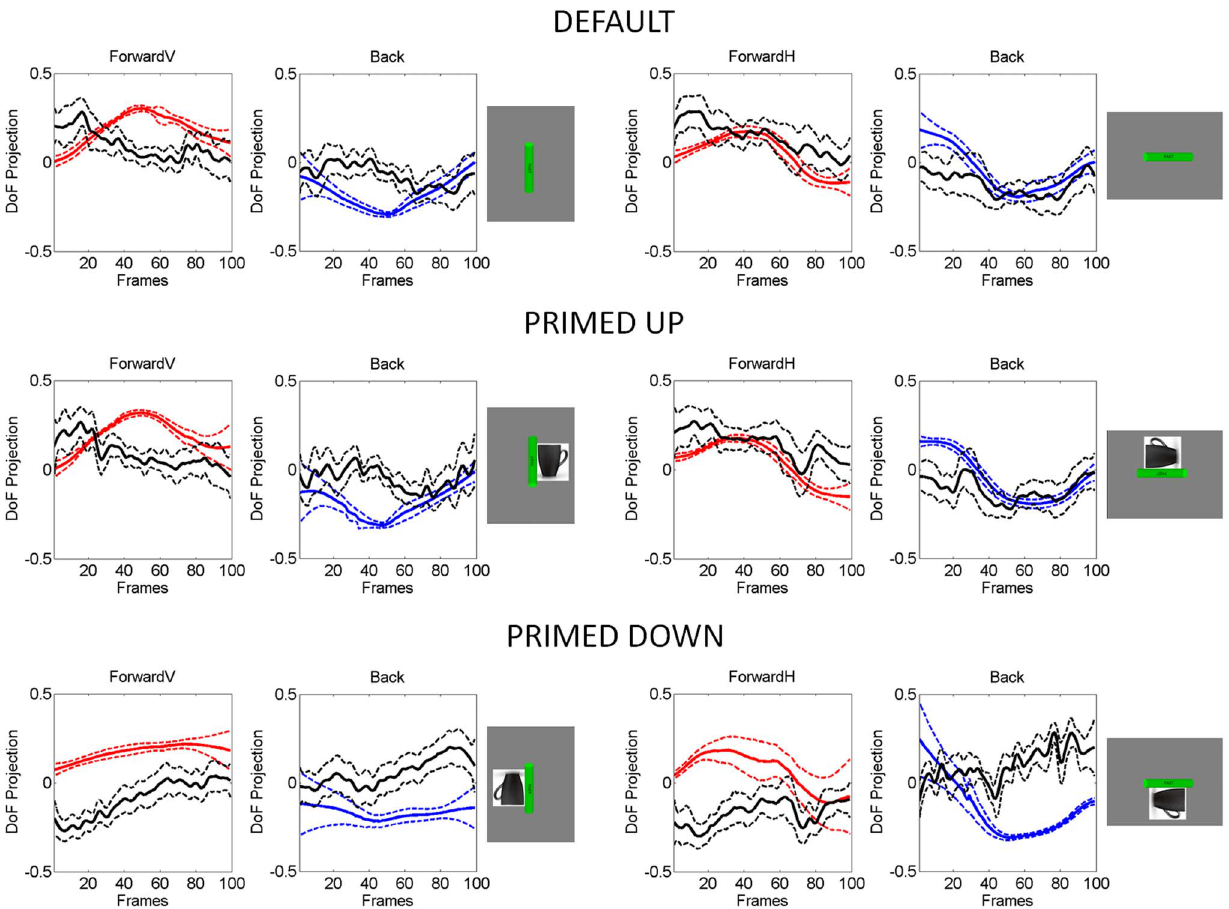
Figure 2. Similar biomechanical constraints for DEFAULT and primed-UP in vertical and horizontal cases contrast with different biomechanical demands between primed-UP and primed-DOWN. Traces are the averaged projection of the degrees of freedom of the arm along the dimensions relevant to the task goals and the dimensions incidental to the goals. These averages are taken across 100 trials for a typical representative and for 100 frames. Red continuous lines are task-relevant DoF forward. Blue are task-relevant DoF retractions and black are task- incidental DoF traces. Dashed lines are the standard deviation from the mean traces. During forward segments and retractions in the same loop the recruitment, release and balance of the degrees of freedom of the arm tend to markedly change as a function of task complexity.